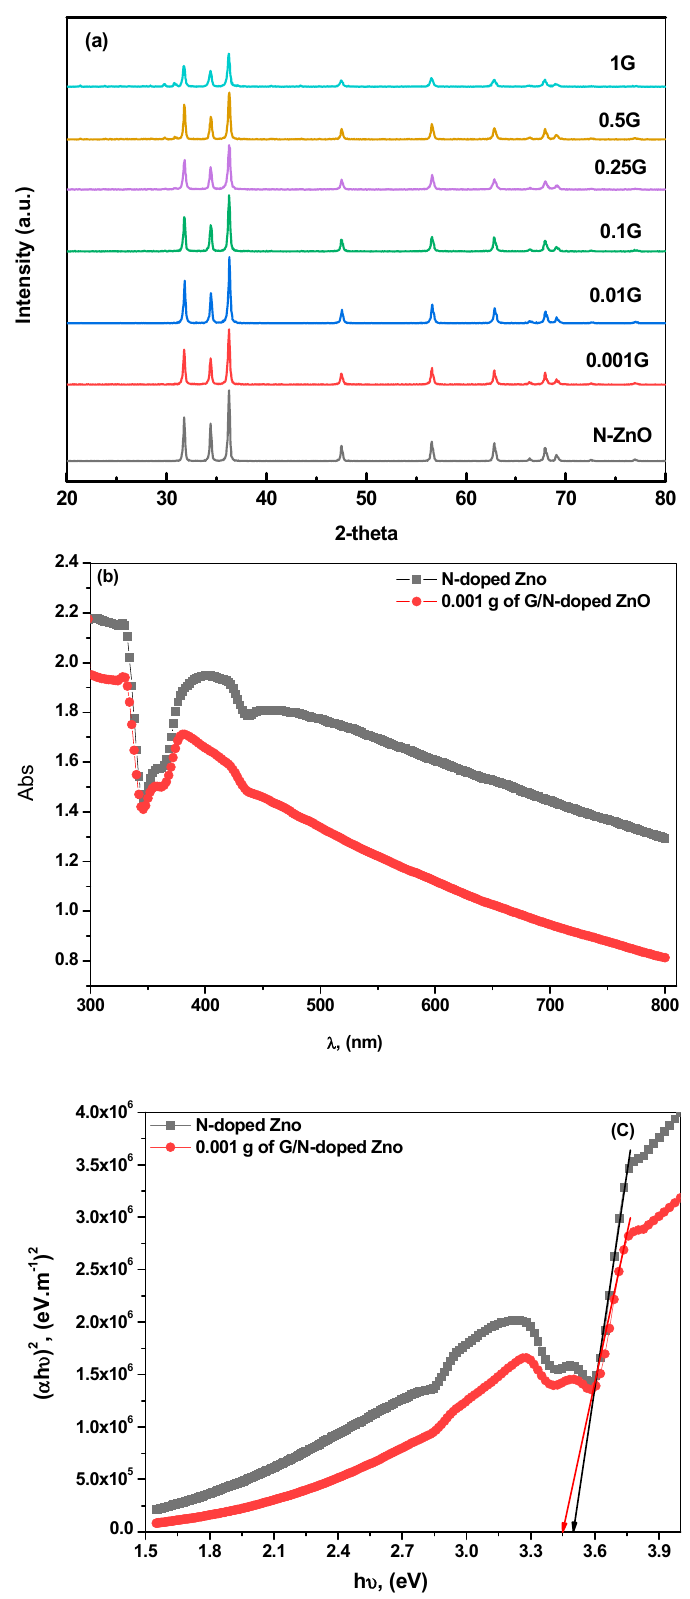
Figure 2. ( a ) XRD patterns of the N-doped ZnO and G/N-doped ZnO nanoparticles with different con- centrations of graphene, ( b ) UV–visible absorbance spectrum of N-doped ZnO and 0.001 G/N-doped ZnO nanoparticles, and ( c ) band gap of N-doped ZnO and 0.001 G/N-doped ZnO nanoparticles. Due to the integration of graphene into N-doped ZnO, no new peaks were identified.